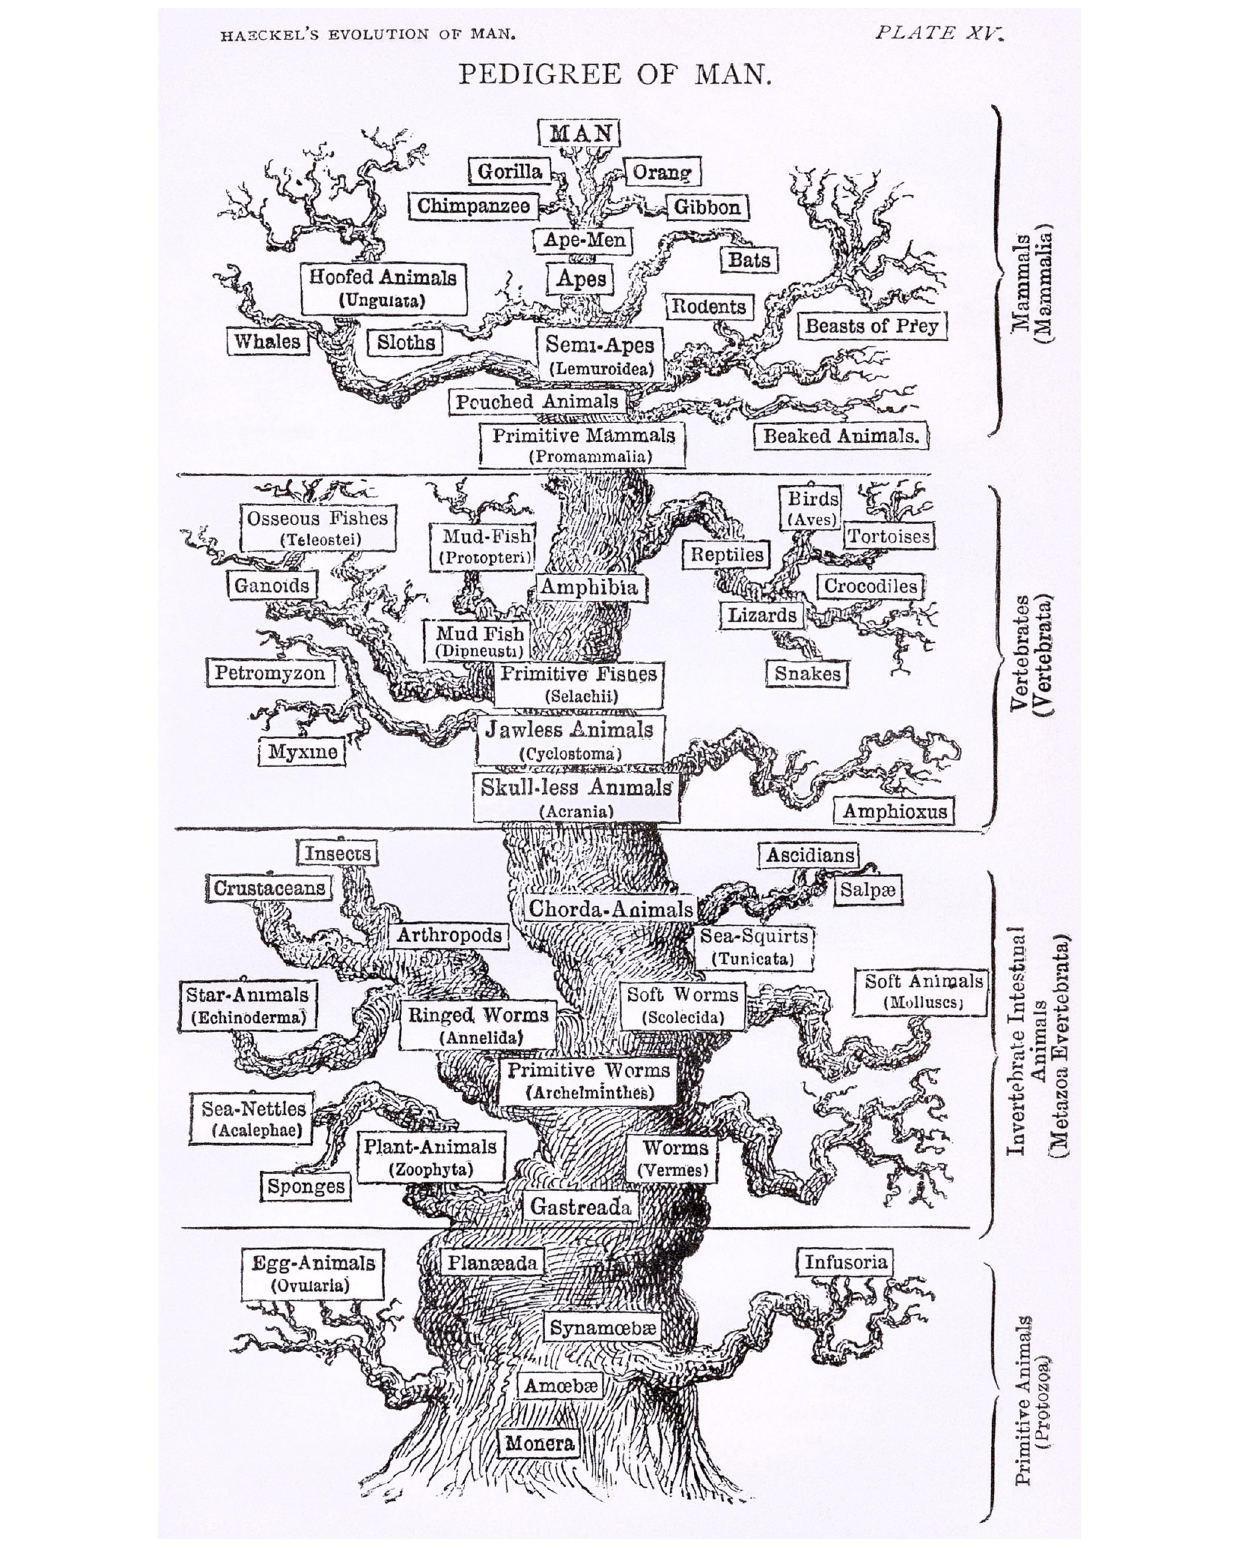
FIGURE 2 | A version of the “tree of life” by Ernst Haeckel, from The Evolution of Man (1879). Attribution: Ernst Haeckel/Public domain.